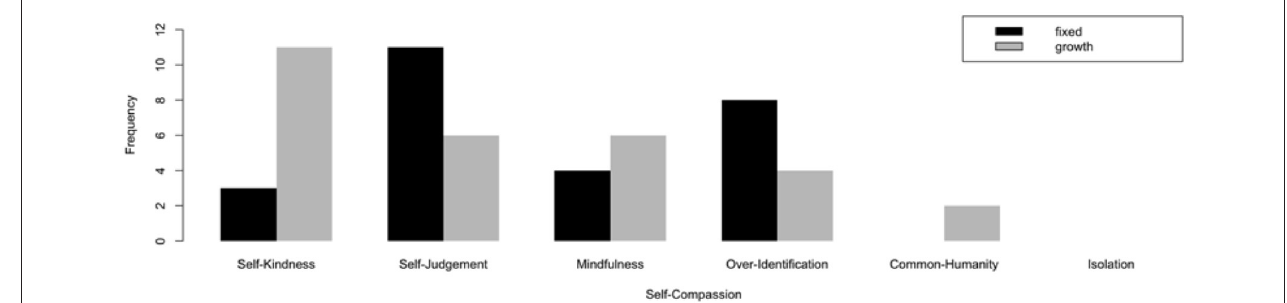
FIGURE 3 | Frequency of self-compassion dimensions across participants with growth vs. fixed